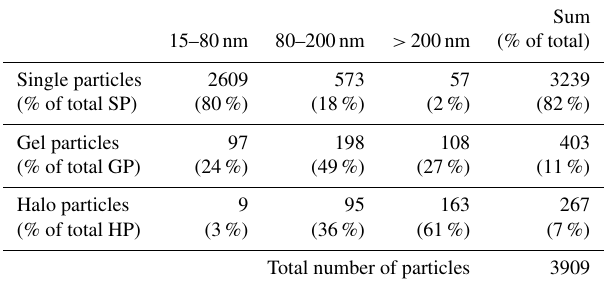
Table 1. Numbers and percentage of total for single particles (SP), gel-like particles (GP), and halo particles (HP) imaged with SEM and used for calculating the number size